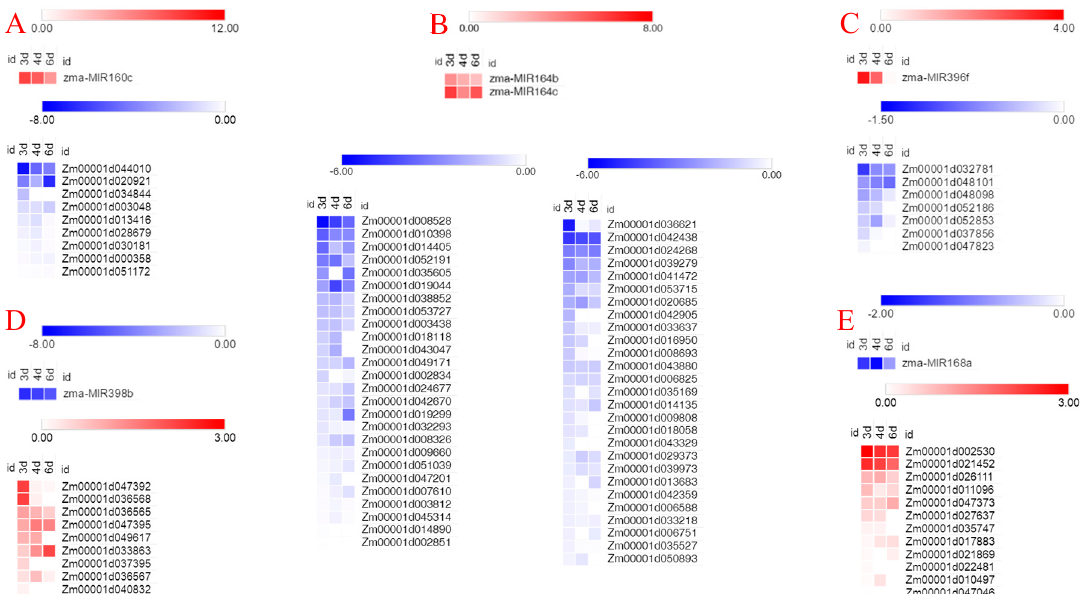
Figure 4. Co-expression patterns of microRNAs and their targets. ( A – E ) shows the expression profiles of different microRNA–mRNA pairs. The color bars show log2-fold change value between elongation region and fixed internode samples. The data are presented in Supplementary Table S6.